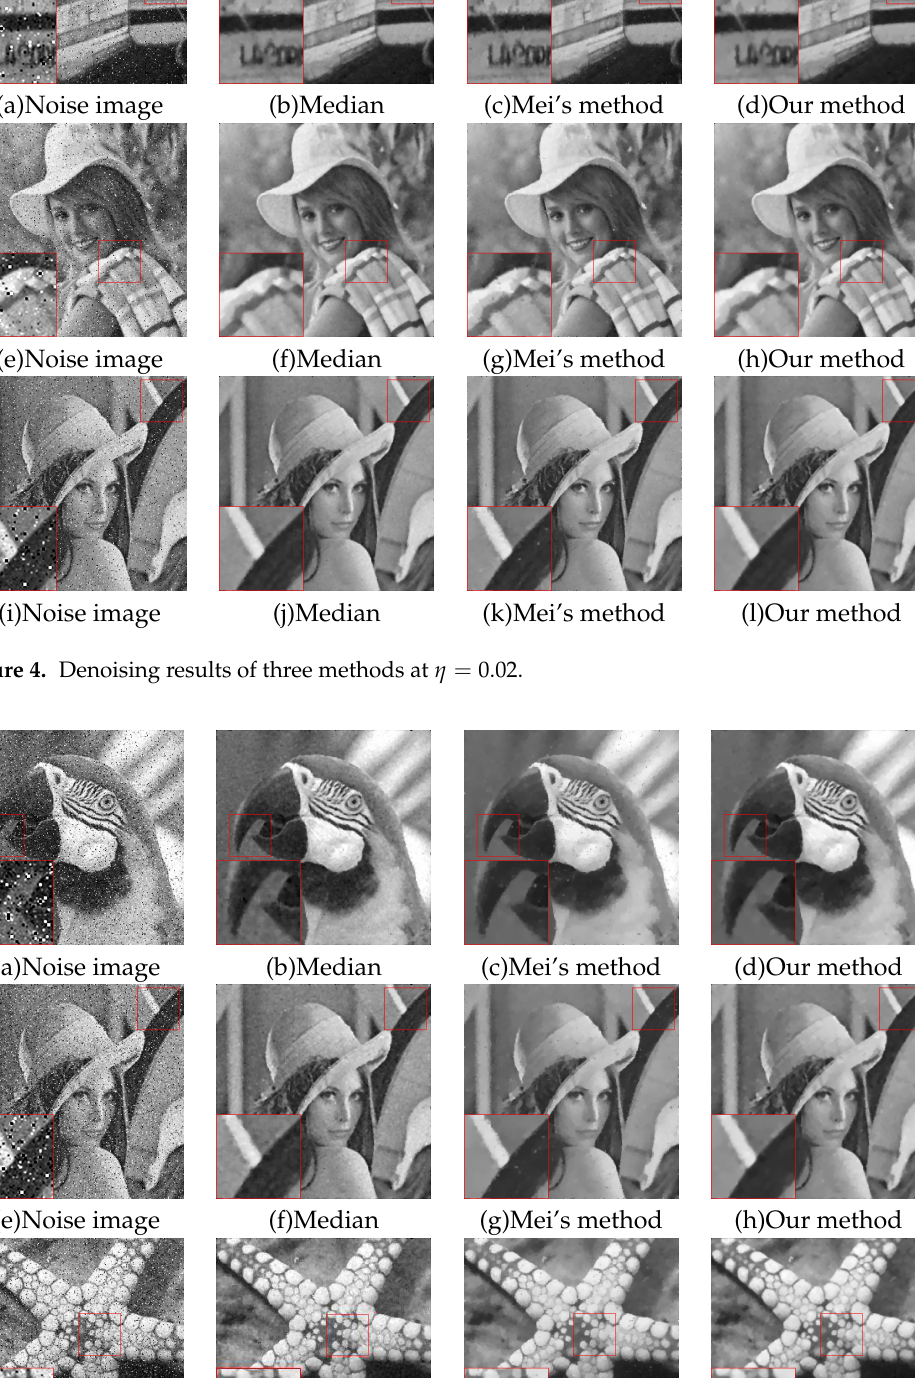
Table 2. PSNR and SSIM values for different algorithms( η = 0.02).